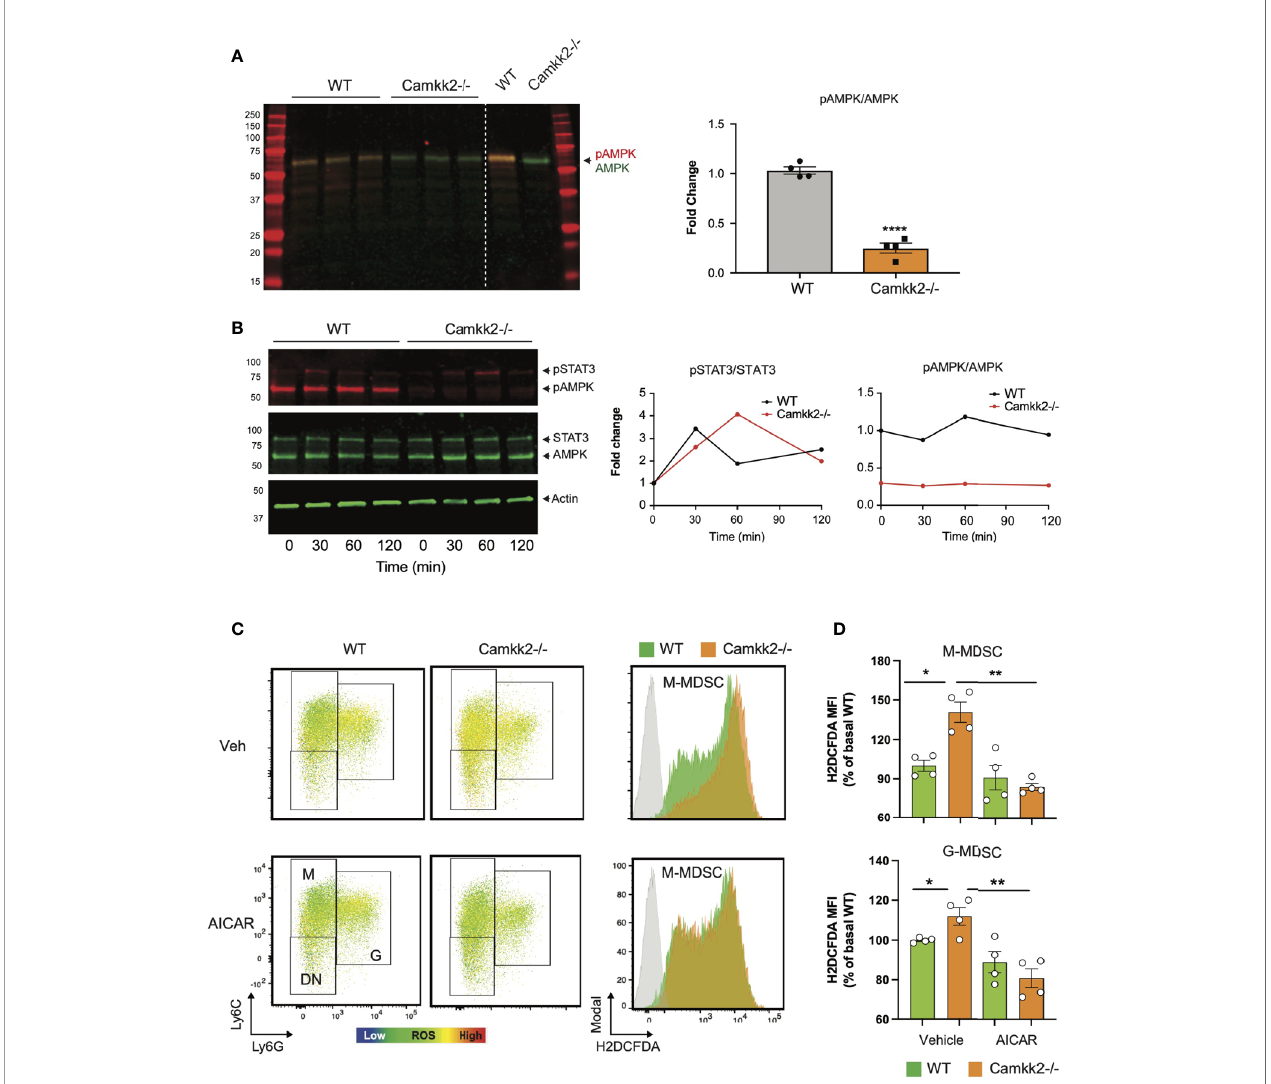
FIGURE 7 | AMPK pathway is the downstream target of CaMKK2 in regulating cellular ROS accumulation. MDSCs were generated in vitro from WT and CaMKK2 -/- BM. (A) Immunoblots of WT and Camkk2 -/- and quantitation of phospho-AMPK (pAMPK) levels (left and right, respectively). (B) in vitro generated MDSC were collected at day 4, washed, and starved 12 hours from cytokines and tumor conditioned mix. MDSC were then recovered and cultured in the presence of IL-6 for the reported time. pSTAT3 and pAMPK immunoblots and quantitation (left and right, respectively). (C) in vitro generated MDSCs were treated with AICAR, (125 m M) or an equal volume of vehicle, for 2 hours. MDSC were then collected and stained for surface markers. ROS were detected by H2DCFDA staining. [ (C) , left panels] representative heatmap dot plots and gating strategy to identify M-MDSC, G-MDSC, and DN subsets. [ (C) , right panels] Representative pro fi les of H2DFDA staining in WT and Camkk2-/- MDSC (green and orange pro fi les, respectively). H2DFDA unstained WT MDSC were used as negative control (Grey pro fi les). (D) Expression of H2DFDA mean fl uorescence intensity (MFI) detected in WT and KO MDSC. Four biological replicates are reported. The results are expressed as percentage basal (average of H2DFDA MFI detected in vehicle-treated WT MDSC). *, ** and **** refer to p < 0.05; 0.01 and 0.001,